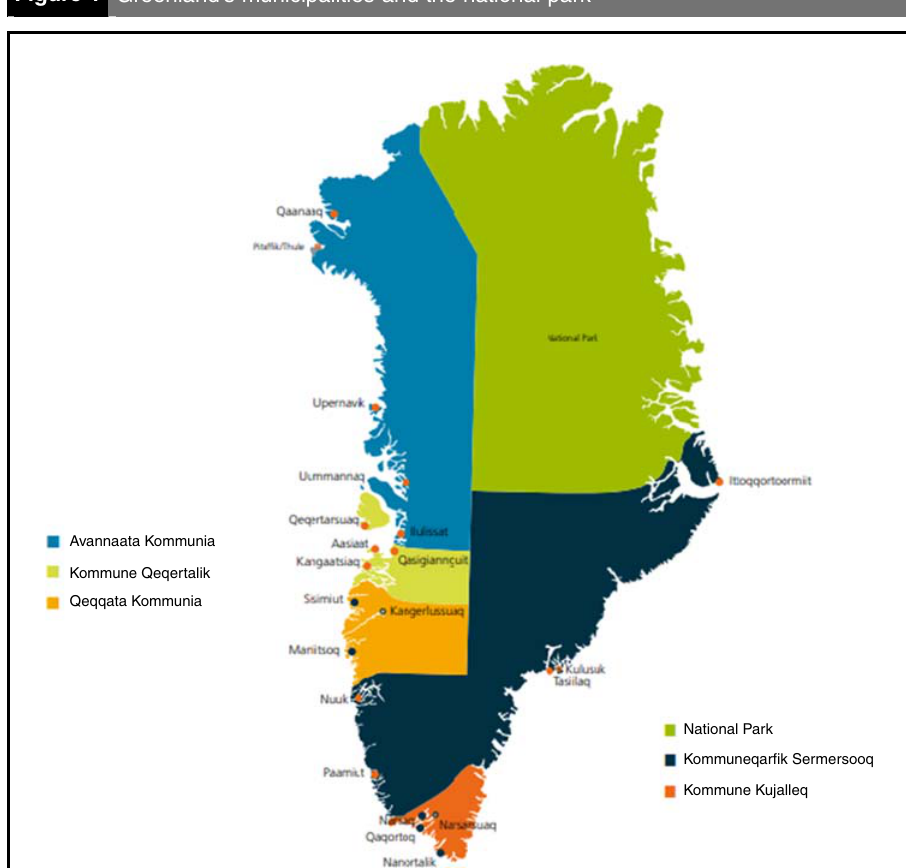
Figure 1 Greenland ’ s municipalities and the national